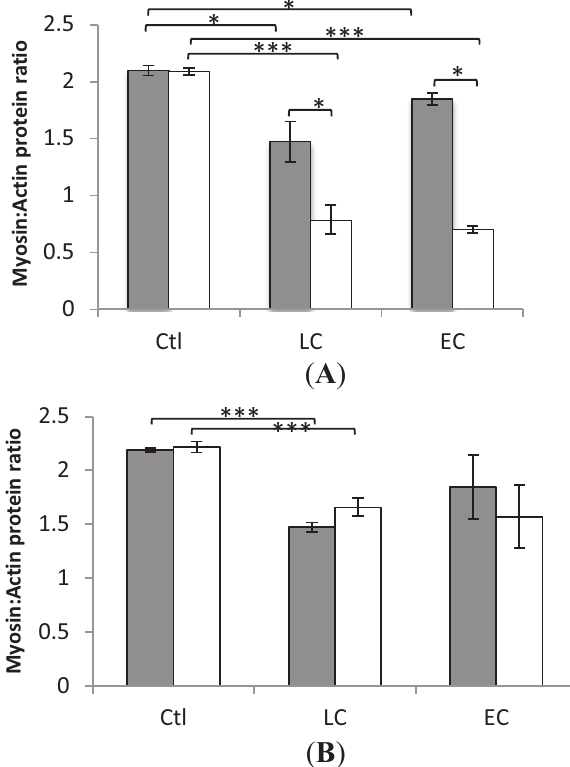
Figure 1. Average myosin:actin ratios. ( A ) Soleus ( B ) EDL. In the individual groups controls (0 Days) (Ctl), LC 10 days (LC), EC 10 – 14 days (EC), loaded (grey) and